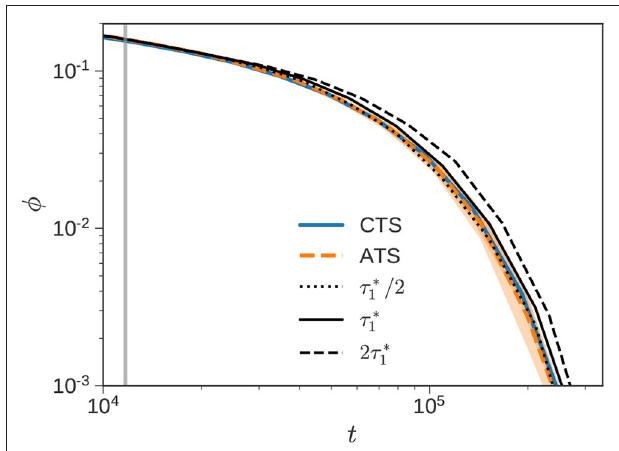
FIGURE 6 | Re-equilibration frequency. Normalized stress relaxation of the bidisperse blend ( ¯ Z 1 = 10, ¯ Z 2 = 40) with w 1 = 0.50 reported in Figure 4B is zoomed in. The CTS (solid blue), ATS (dashed orange), and τ ∗ 1 (vertical gray) lines are identical. The dashed, solid, and dotted black lines denote ATS simulations performed with constant T re = 0.5 τ ∗ 1 , τ ∗ 1 , and 2 τ ∗ 1 ,